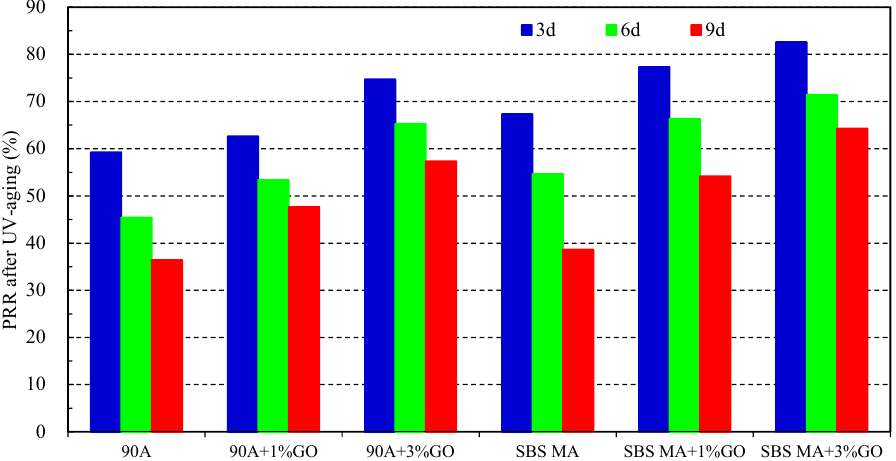
Figure 4. The PRR of asphalt after UV aging.